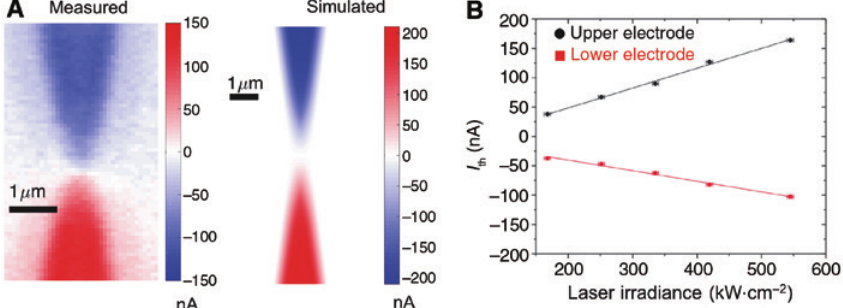
Figure 3: Thermocurrents at no bias. (A) Thermocurrent maps at zero bias, I ( x , y ), obtained after scanning the structure under the laser focus (measured), and from simulation th in the thermal and electromagnetic domains (simulated). (B) Dependence of the magnitude of the thermocurrent with incident laser power (data points) when the focal spot is located on either the upper electrode or lower electrode. The lines are linear fits to the